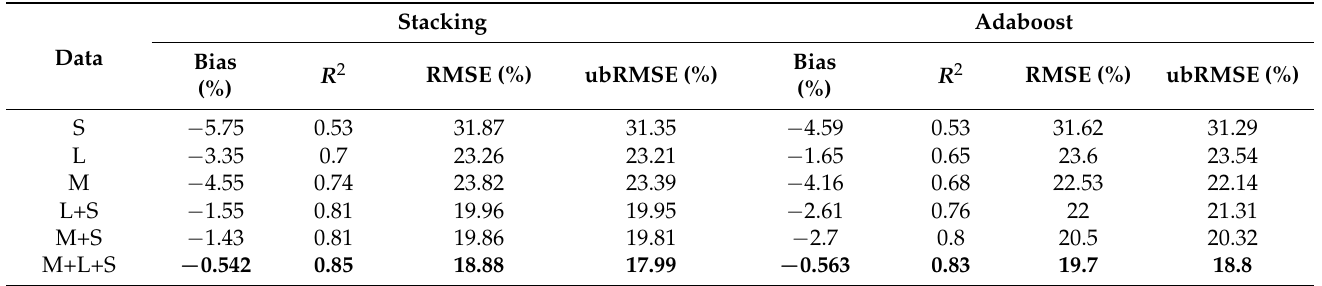
Table 5. Performances of different ensemble learning